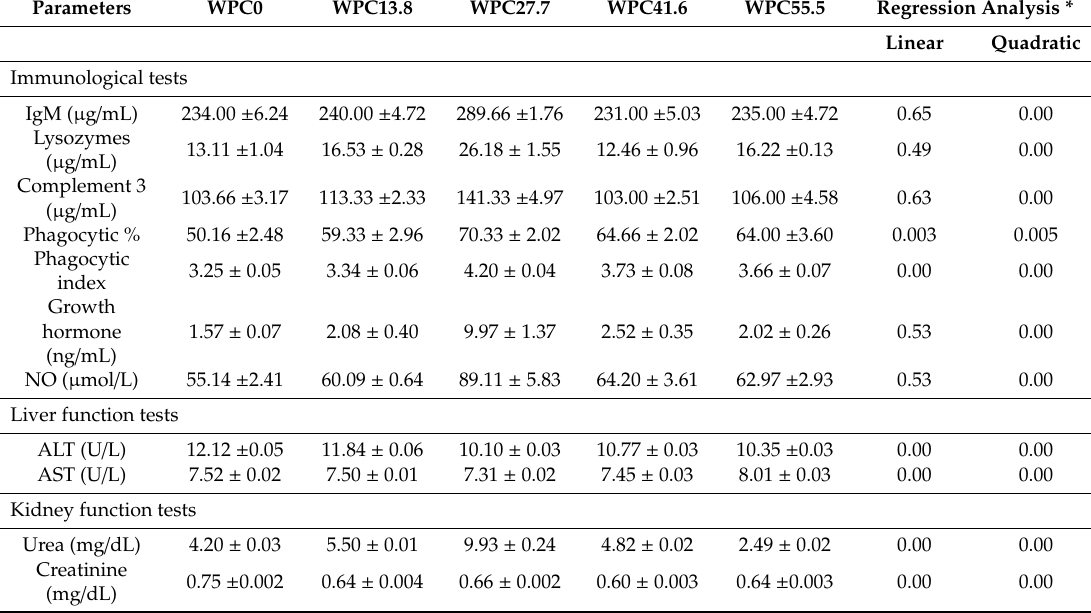
Table 4. The e ff ect of partial replacement of fish meal with whey protein concentrates on immune status, blood levels of growth hormone and nitric oxide, and kidney and liver function tests of Nile tilapia fingerlings after bacterial challenge